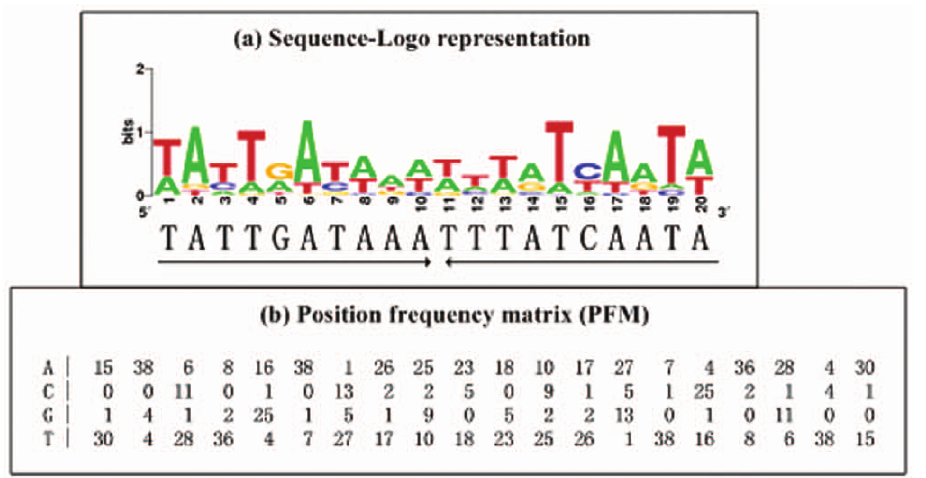
Figure 3. MQSR consensus constructs. (a) The sequence logo representation of the binding sites of OpaR and its orthologs (Table 2) was generated by the WebLogo tool [27]. The 20-bp consensus box TATTGATAAA-TTTATCAATA was annotated as an inverted repeat sequence. (b) A position frequency matrix describes the alignment of the binding sites, and denotes the frequency of each nucleotide at each position.